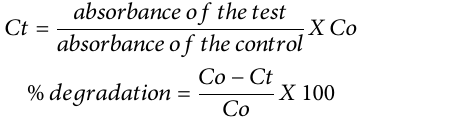
Table S1 . All the absorbance spectra registered peaks ranging from 225 to 230 nm, Figure 1